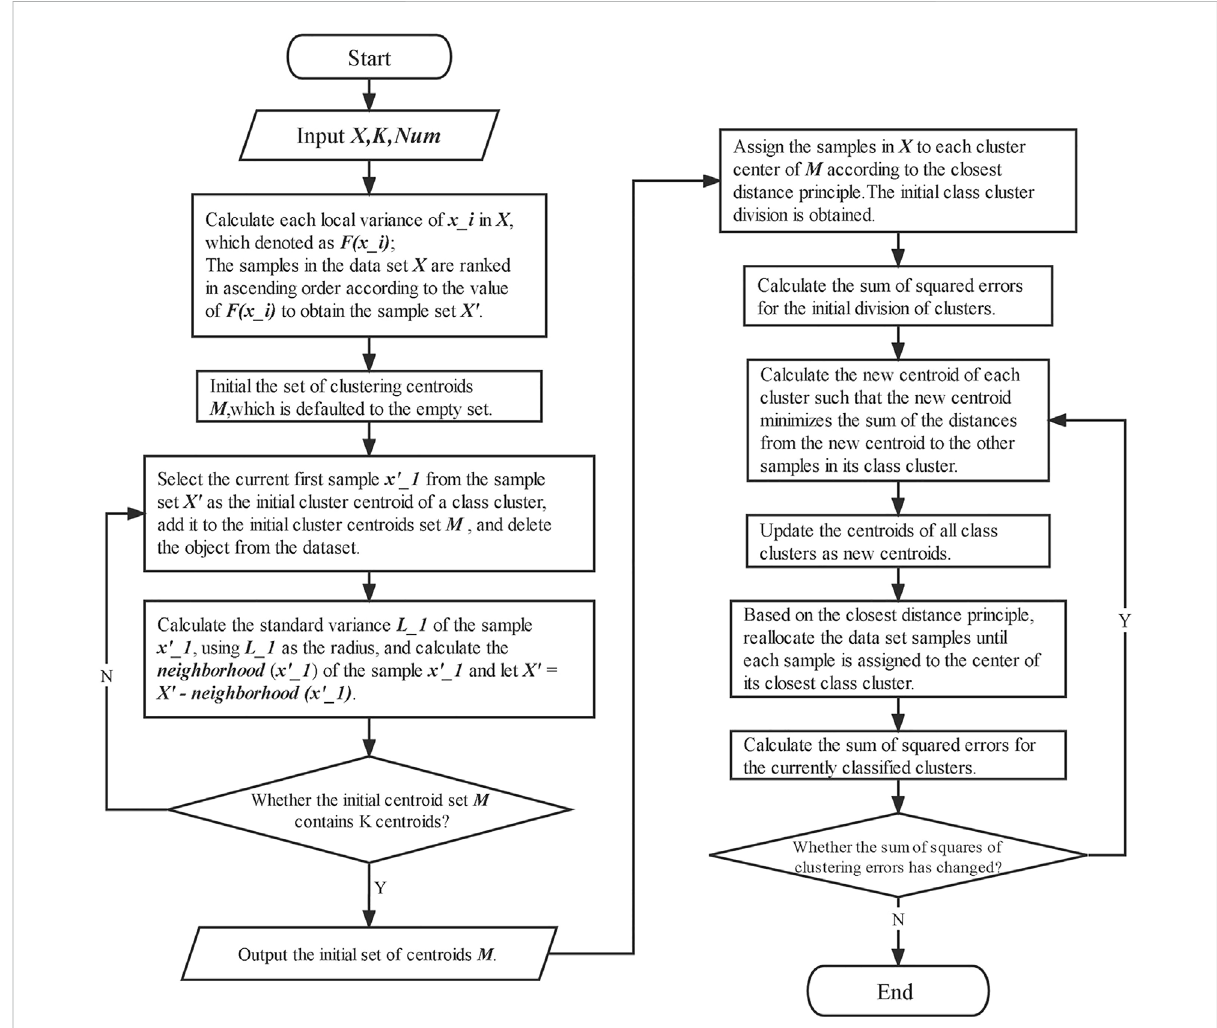
FIGURE 1 Flow of Num-near neighborhood K-medoids clustering based on local